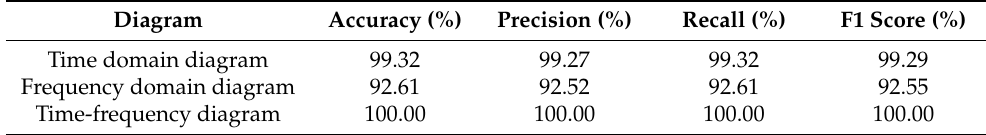
Table 2. The training results of different diagrams.